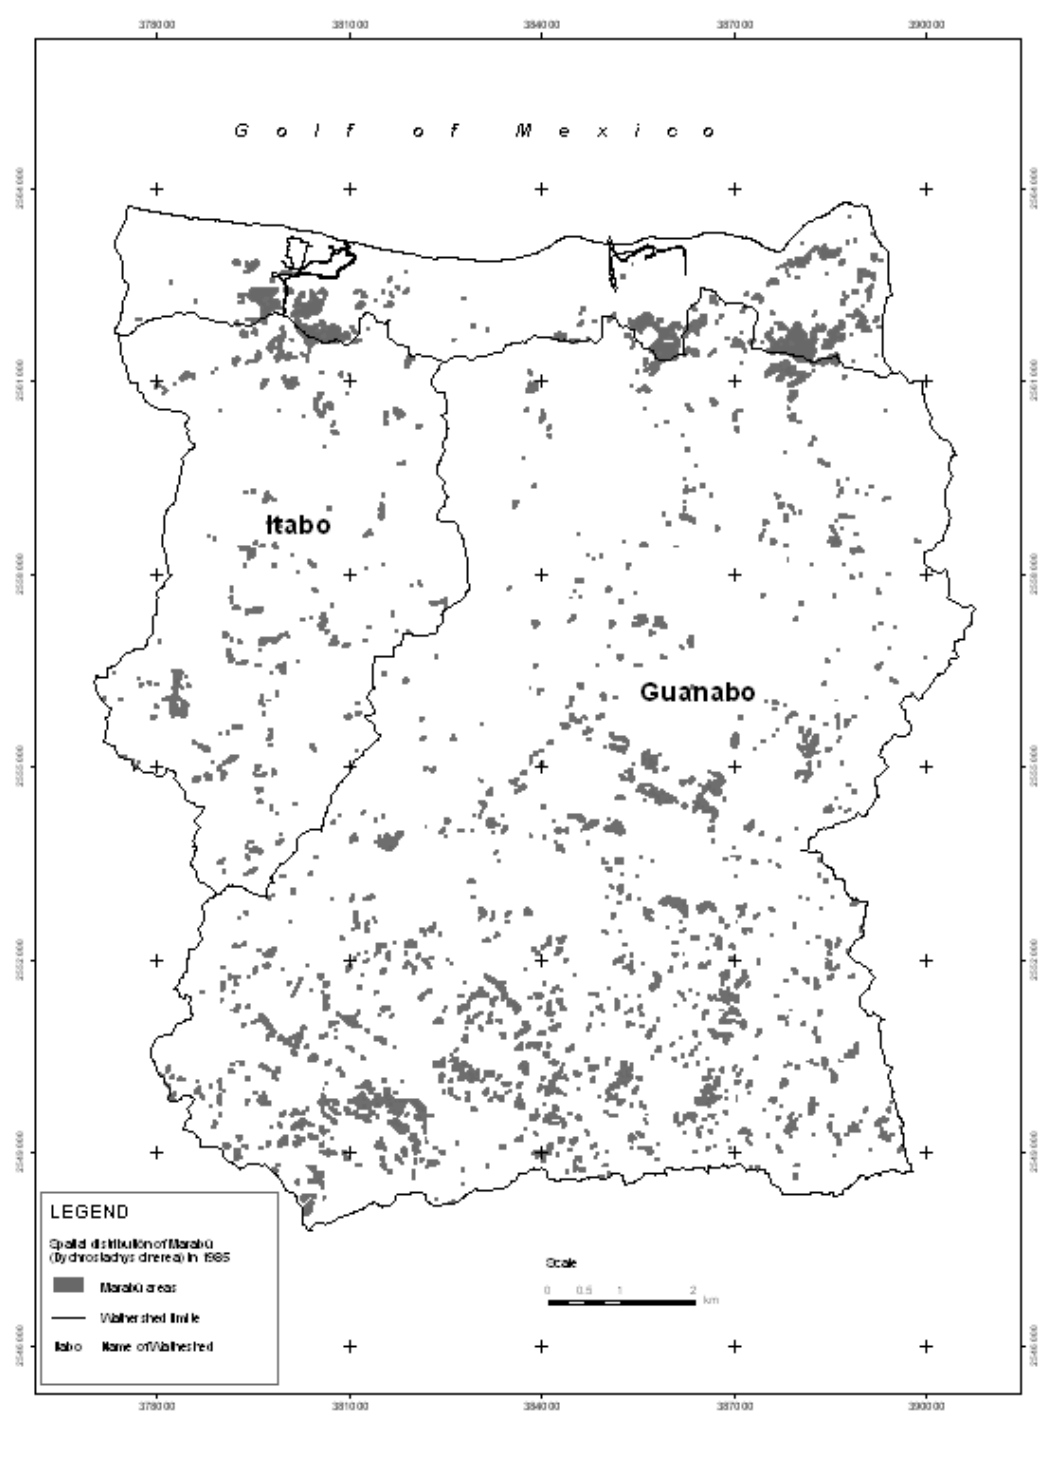
Figure 2. Spatial distribution of Marabú ( Dychrostachys cinerea ) in